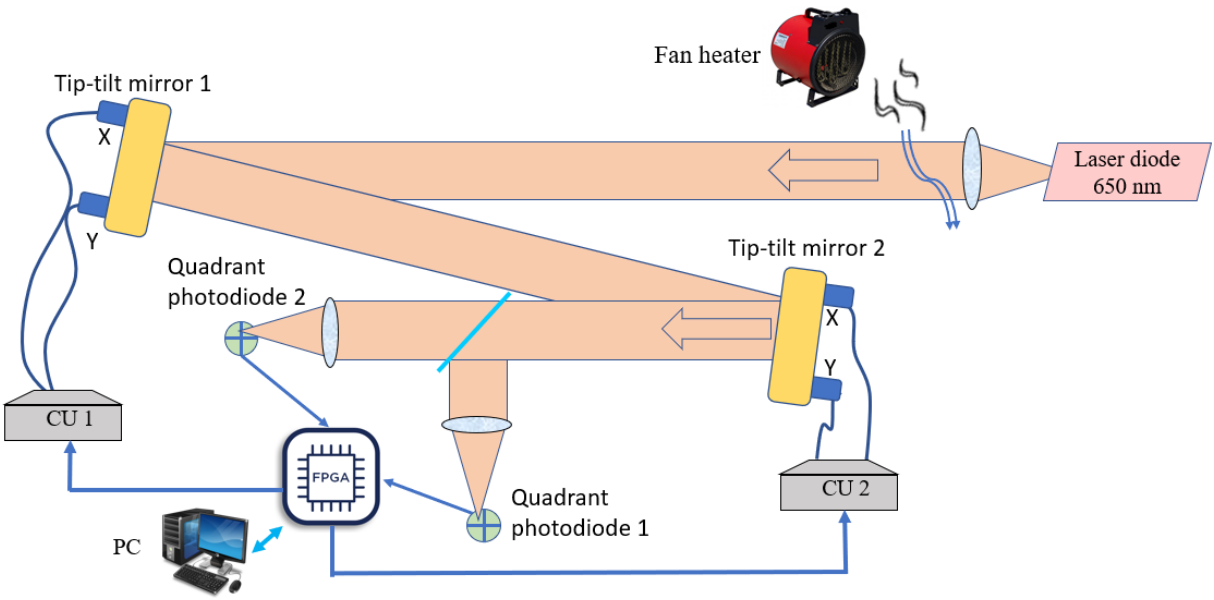
Figure 7. Beam-stabilization system.